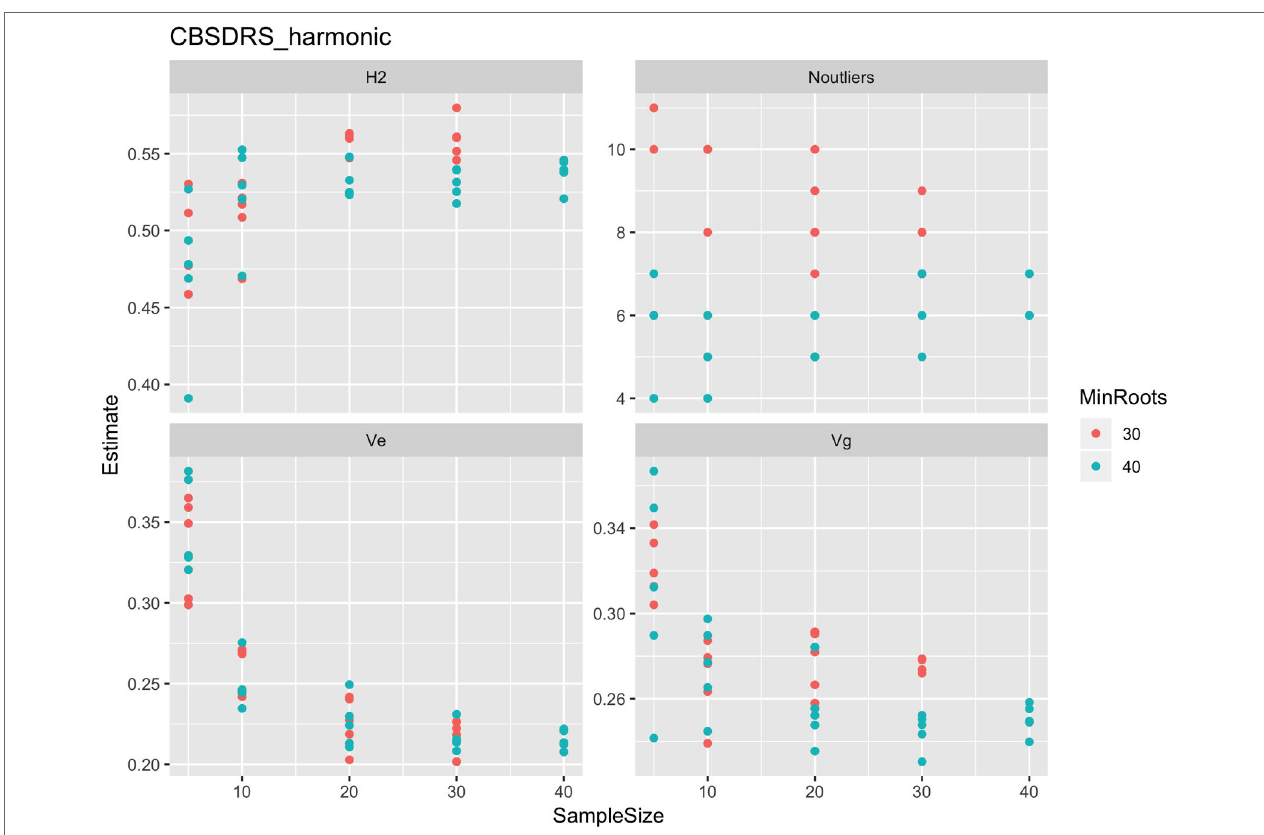
FiGURe 5 | Influence of root sample sizes on cassava brown streak disease root severity computed as harmonic mean (CBSD-Harmonic). H 2 , broad-sense heritability; Ve, error variance component; Vg, genetic variance component; Noutliers, number of outliers. Analysis based on resampling of 5, 10, 20, 30, or 40 roots from each plot at